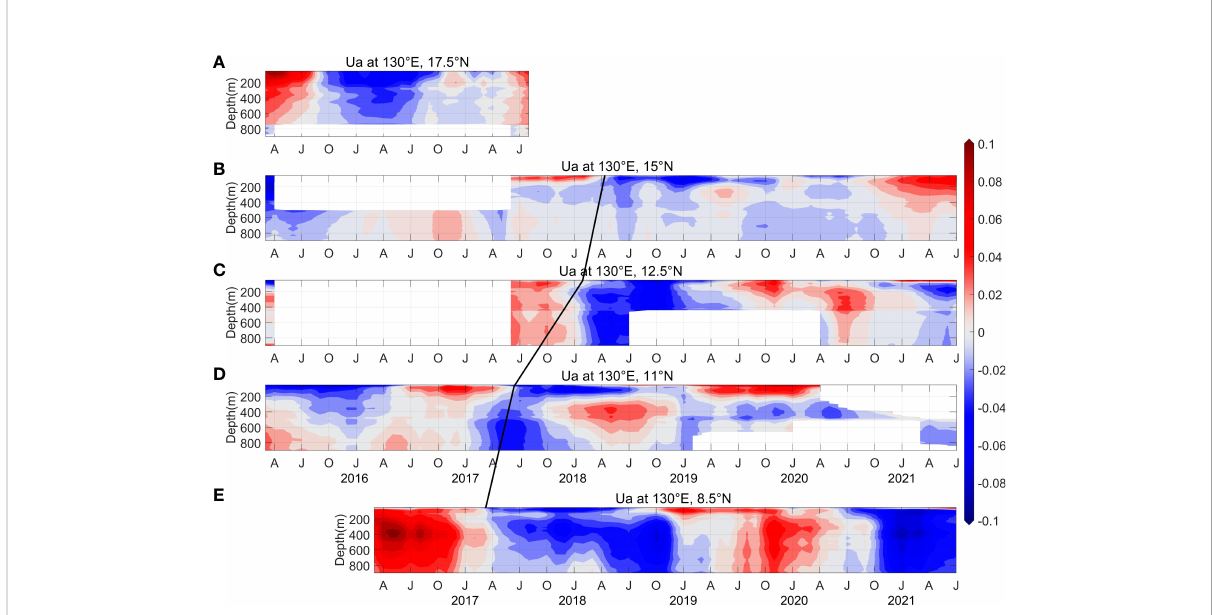
FIGURE 4 Time series of zonal velocity anomalies (m/s) derived from mooring ADCP measurements at (A) 17.5°N, (B) 15°N, (C) 12.5°N, (D) 11°N, and (E) 8.5°N along 130°E. All the time series have been smoothed with a 1-year low-pass fi